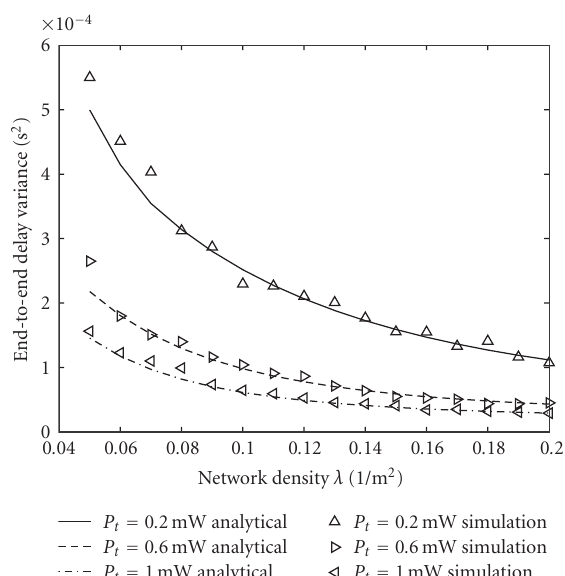
Figure 9: Delay variance versus network density λ ( l = 160 m).